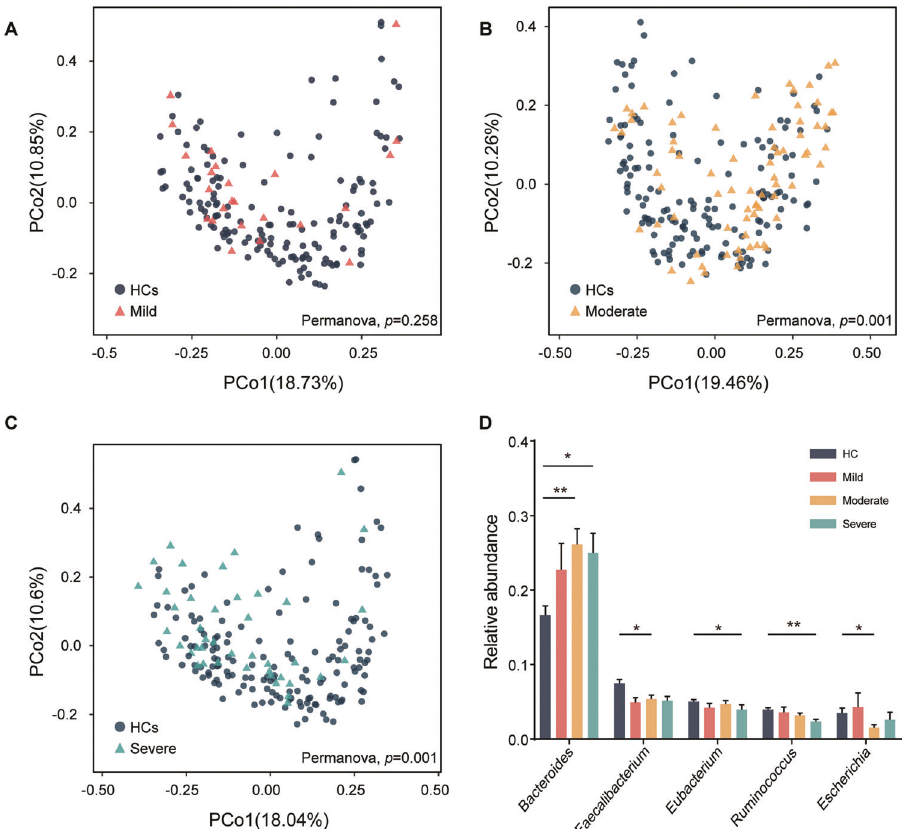
Fig. 2 Gut microbial characteristics among HCs and MDD subgroups. A – C Principal co-ordinates analysis (PCoA) was conducted based on species level and Bray-Curtis distance. PERMANOVA test showed that the general characteristics of microbiota in moderate and severe groups were signi fi cantly different from HCs, while there was no signi fi cant difference between mild group and HCs. In addition, we did not fi nd the separated characteristics of microbiota by comparing disease subgroups (see Fig. S2). D The bar plot showed the differentially enriched genus in the most top 10 high relative abundance genus. Bacteroides was signi fi cantly increased in moderate and severe group, while the reduction of 2 genera ( Faecalibacterium and Escherichia) in moderate group and 2 genera ( Eubacterium and Ruminococcus) in severe group,